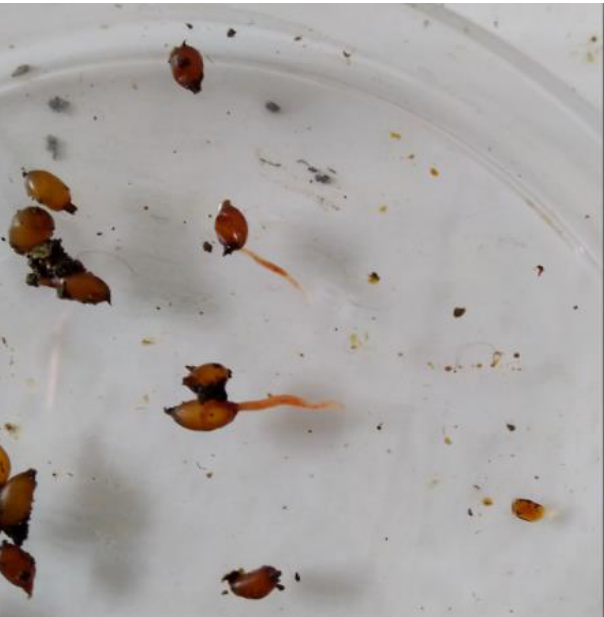
Figure 3. Hatchlings of earthworms coming out of cocoons.